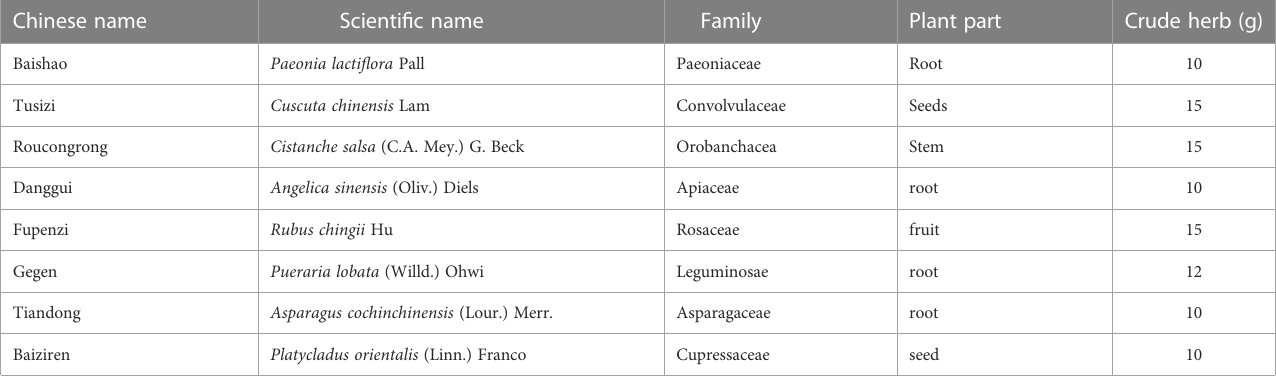
TABLE 1 He ’ s Yang Chao recipe (HSYC)